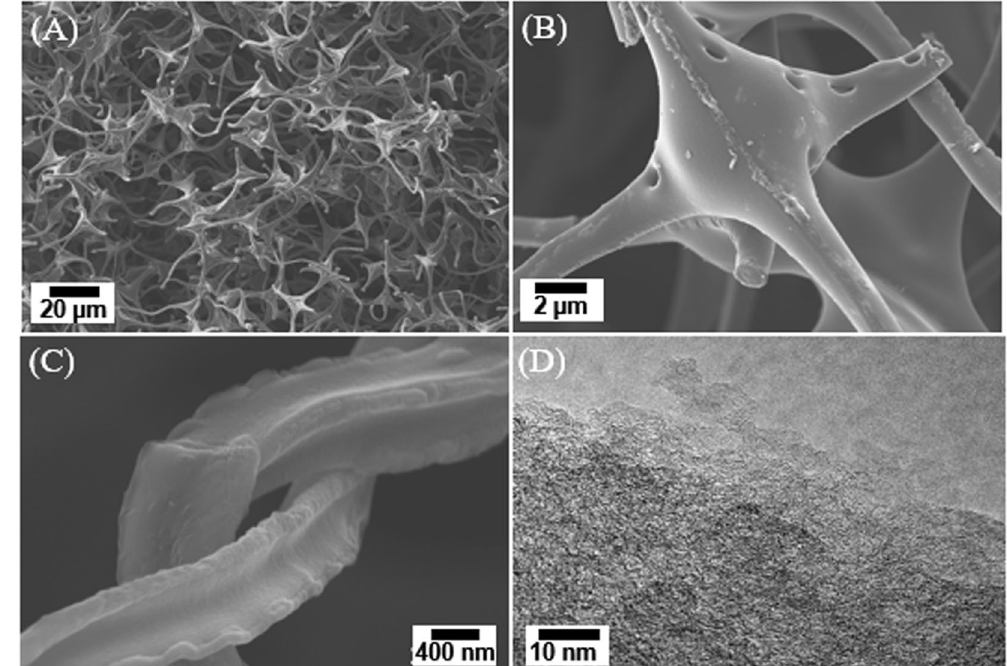
Figure 1. Top view SEM images of ECF at ( A ) low and ( B , C ) high magnification, respectively; ( D ) high- resolution TEM image of the thin edge of ECF.